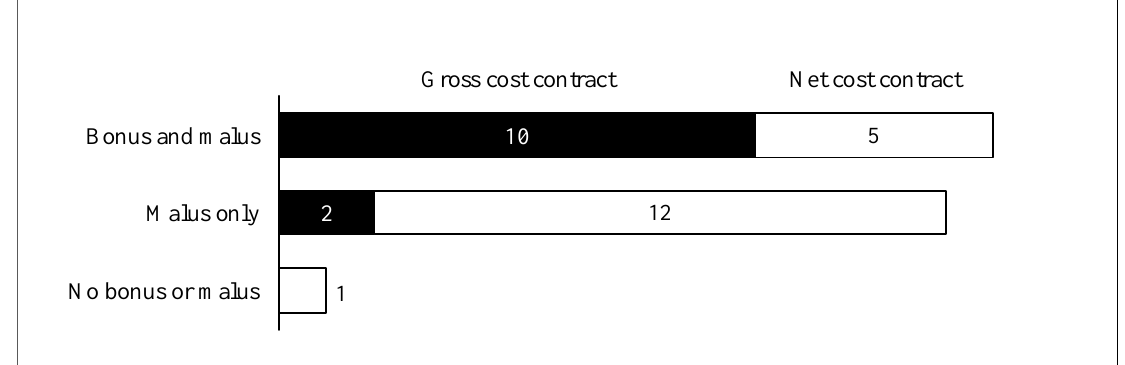
Figure 6. Frequency distribution of bonus-malus schemes compared to type of contract Nevertheless, net cost contracts generally provide better incentives than gross cost contracts, since the operator’s revenue is at least partly connected to the quality of its performance on